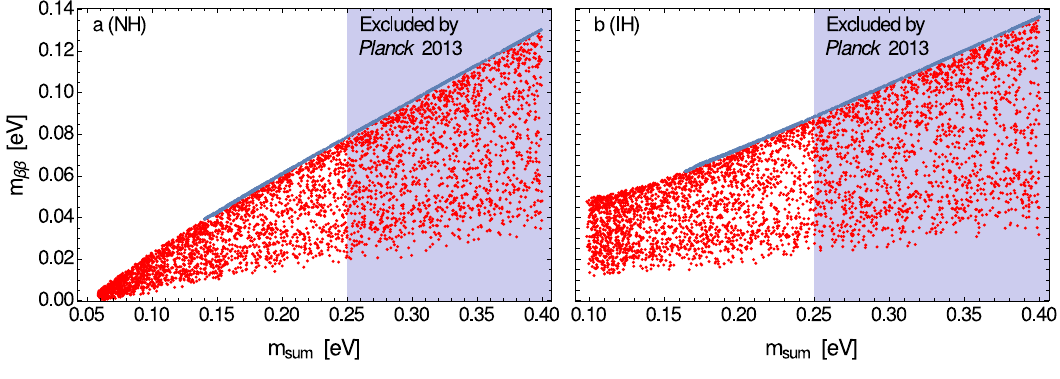
Figure 1 . Scatter plots of m ββ versus m sum . Figure 1a is for a normal ordering of the neu- trino masses and figure 1b is for an inverted ordering. The red points take into account only the experimental bounds (3.2)–(3.4); the blue points arise from the constraints (3.1).